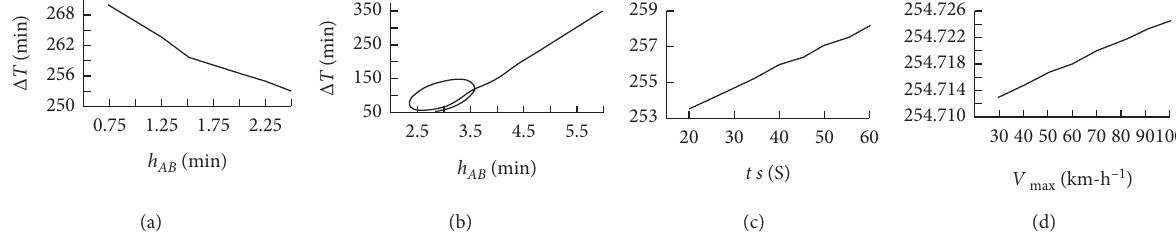
Figure 5: Schematic diagram of the relationship between the changes in the parameter and Δ T . (a) The impact of departure interval h Δ T . (b) The impact of departure interval h A/B on Δ T . (c) The impact of stop interval t s on Δ T . (d) The impact of maximum speed V max on Δ T